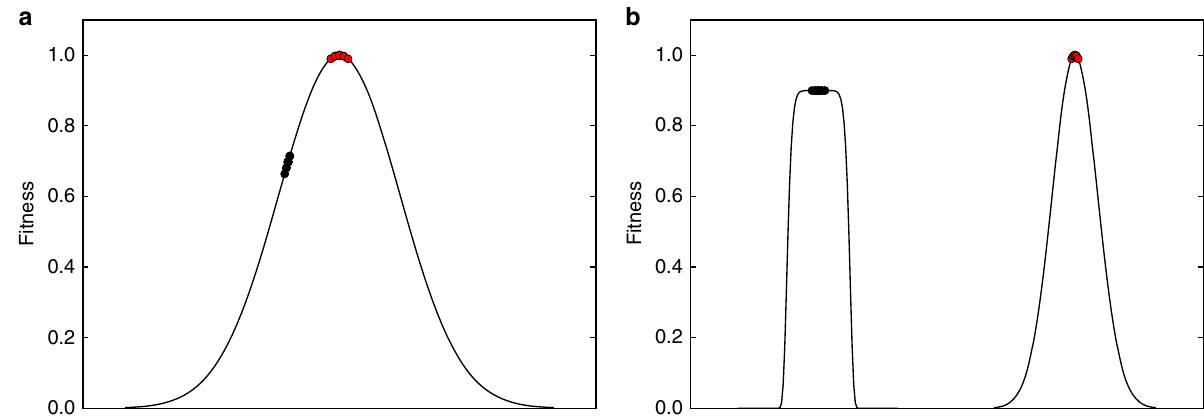
Fig. 1 Conceptual diagram of drift robustness. a A single-peak fi tness landscape. In this landscape, the large population ( red circles ) can climb to the top of the fi tness peak, while the small population ( black circles ) can only maintain fi tness on an intermediate part of the peak. b A multi-peak fi tness landscape. The large population evolves to the same fi tness peak as in a . The small population evolves to the steeper, drift-robust peak. While this peak is still lower than the drift-fragile peak, the small population attains greater fi tness than it would have on the drift-fragile peak in the single-peak fi tness